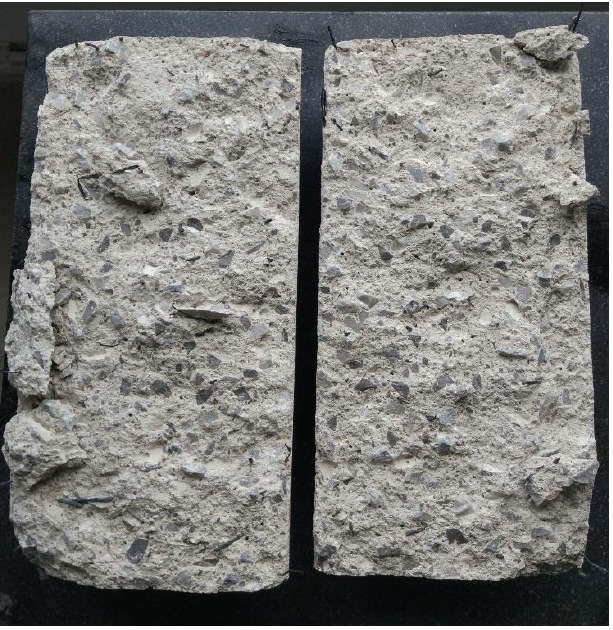
Figure 15. Breaking surface of a cylindrical specimen after a tensile splitting strength test.